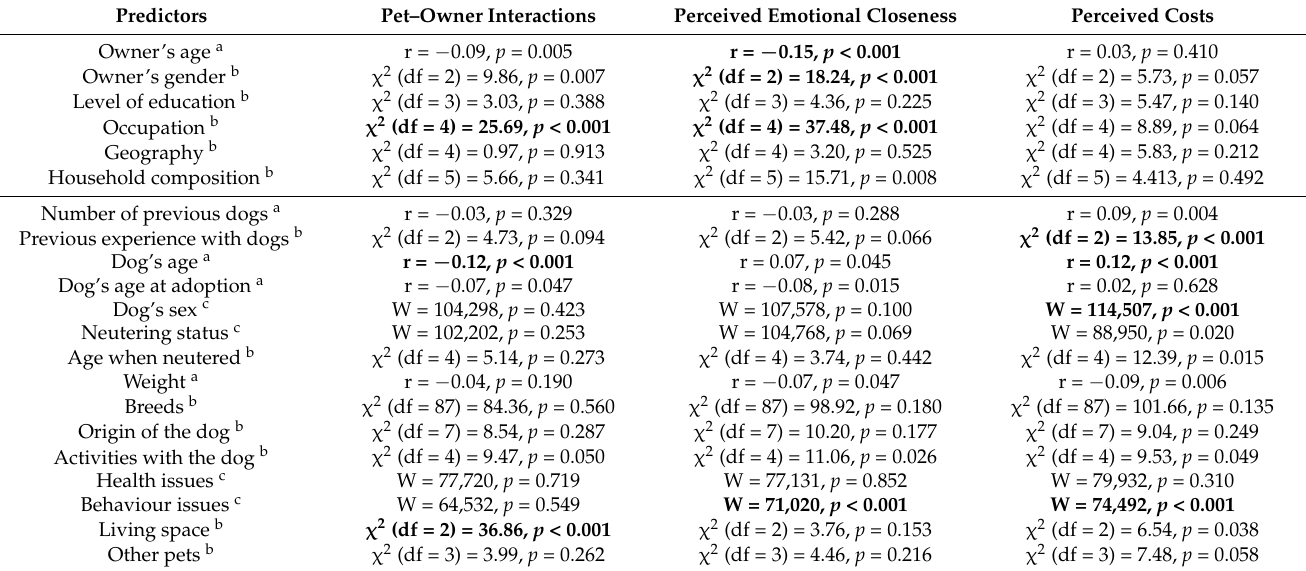
Table 6. Variables selections for the C/DORS regression